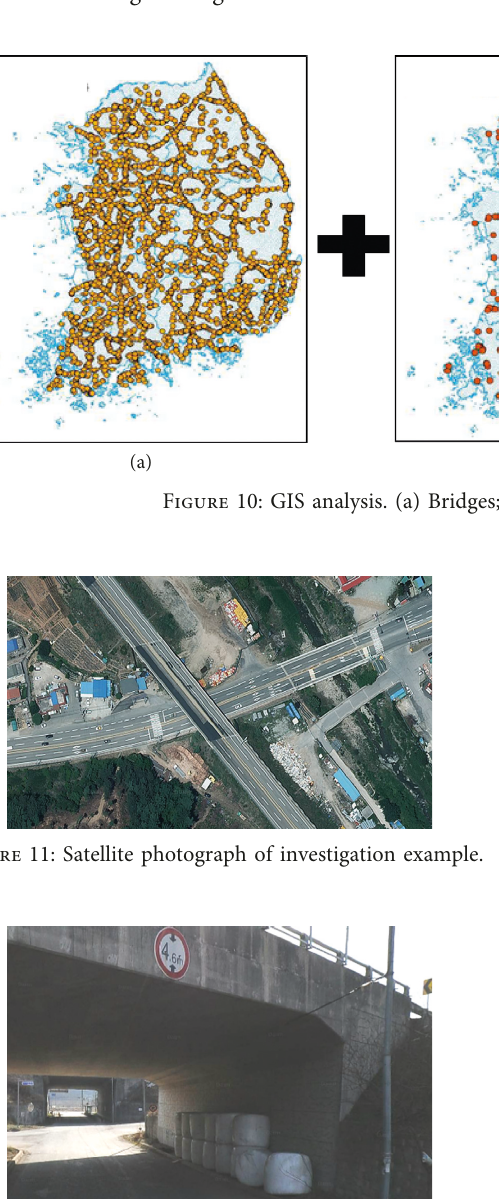
Figure 12: Road level photograph of investigation